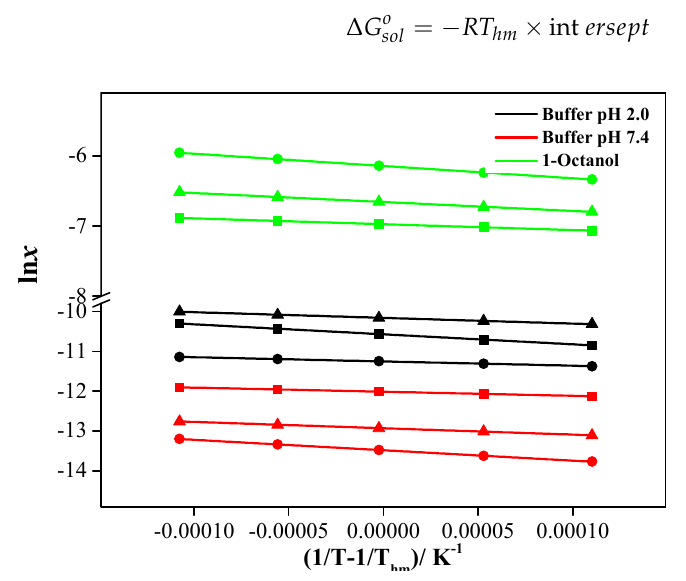
Figure 6. Van’t Hoff plot of lnx versus (1/ T - 1/ T hm ) for compounds I–III in solvents used: ▲ —I; ● —